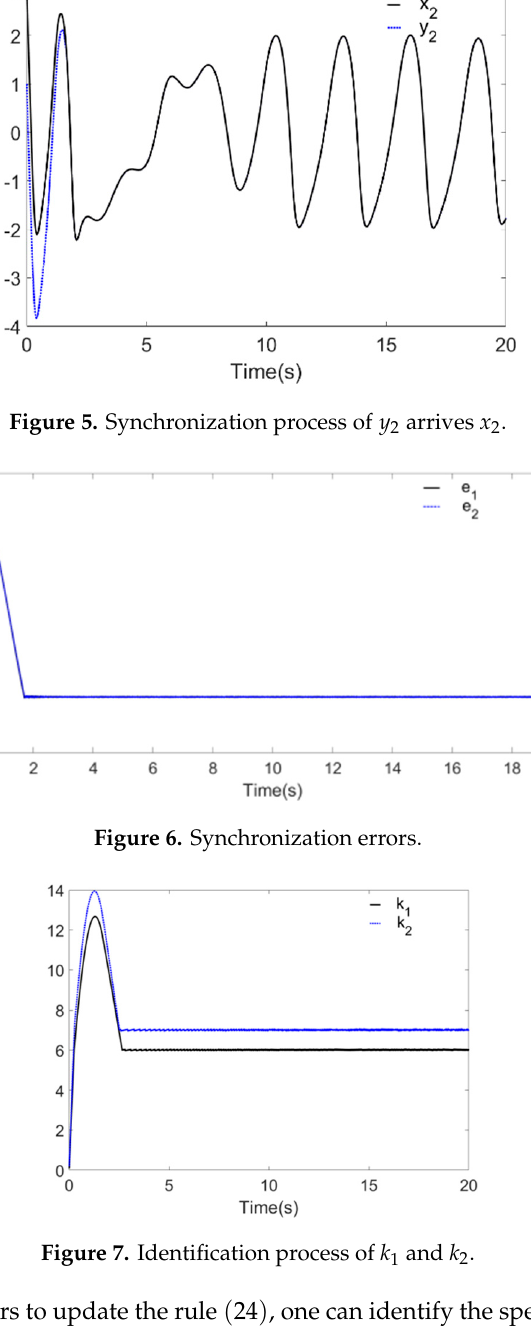
y x arrives 1 . y x y arrives 1 . arrives